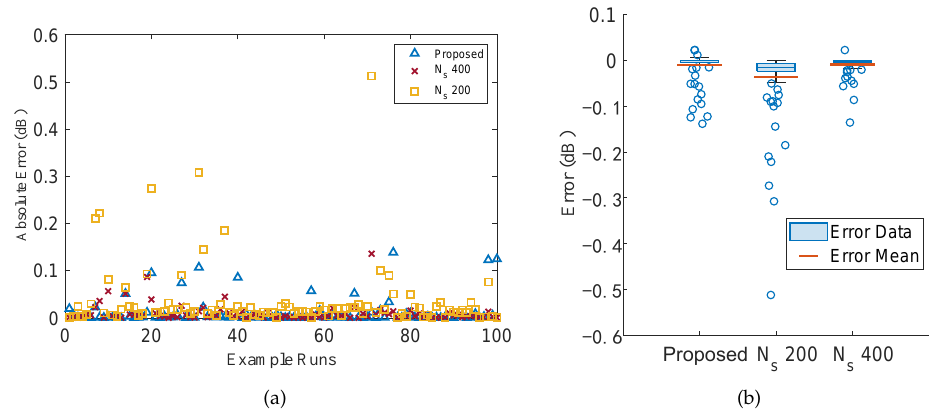
Figure 5. Error performance of example Section 3.2. ( a ) Absolute error analysis. ( b ) Boxplot of errors.